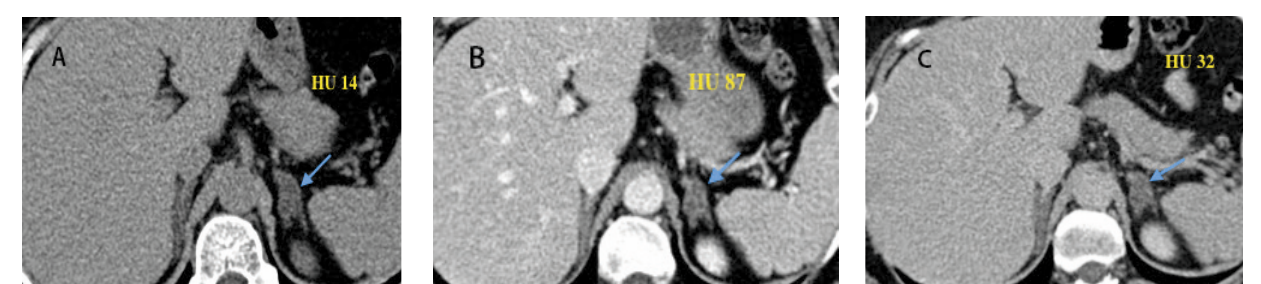
Fig. 14. Adrenal incidentaloma. A 72-year-old woman had a CT scan performed for non-specific lower abdominal discomfort. The CT findings were unremarkable except for an incidentally detected left adrenal mass. (A) Pre-contrast axial CT image shows a left adrenal mass with a CT density measuring 14 HU (blue arrow). (B). Post-contrast 60 seconds measures 87 HU (blue arrow). (C). Post-contrast 15 minutes’ delay 32 HU (blue arrow). The lesion is indeterminate by unenhanced CT attenuation criteria (HU >10) alone and does not permit accurate characterisation of the lesion. Washout analysis :